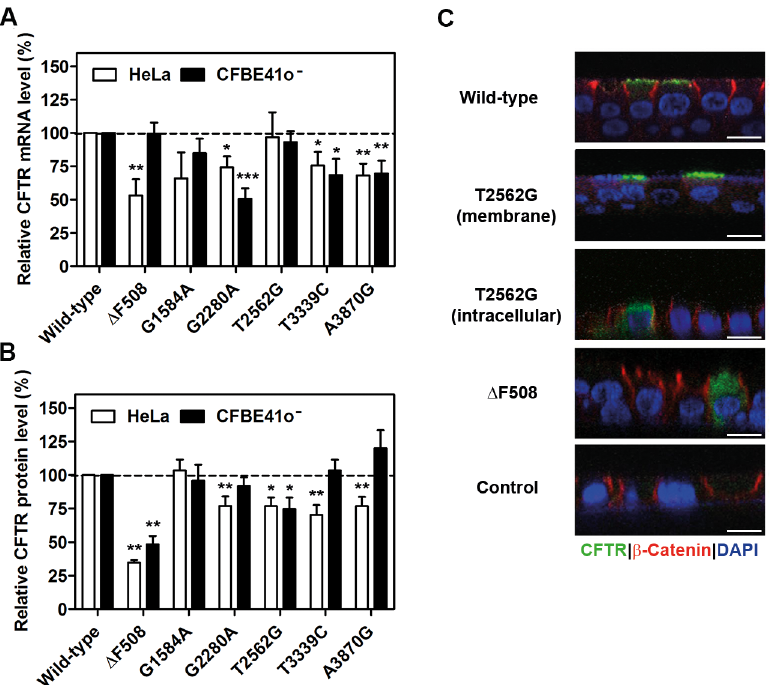
Fig 1. Synonymous mutations alter cystic fibrosis transmembrane conductance regulator (CFTR) expression. ( A ) Quantitative real-time PCR (qRT-PCR) quantificationof steady-state CFTR mRNA expressionin HeLa and CFBE41o - cells analyzed24 h after transfectionand normalized to neomycin phosphotransferase (NPT). The mRNA level of wild-type CFTR was set to 100%. ( B ) Total steady-state CFTR expression(i.e., the sum of bandsB and C in S1B Fig) normalized to that of NPT and β -actin(ACTB) and related to wild-typeCFTR, which was set to 100%. In A and B, data are means ± SEM (A: HeLa, n = 3–7; CFBE41o - , n = 4–9; B: HeLa, n = 5–14; CFBE41o - , n = 4–7); * P < 0.05, ** P < 0.01, *** P < 0.001 versus wild-typeCFTR. ( C ) Representative immunostaining images ( n = 3) of well-differentiated humancystic fibrosis (CF) airway epithelia.The frequencyof intracellularversus membrane-localizedT2562G-CFTR stainingwas as follows: 44% of T2562G-CFTR–expressing cells exhibitedintracellularstaining (12 out of 27) and in 55% (15 out of 27), staining was membranelocalized.The perinuclear stainingdemonstrates the intracellular localization of T2562G-CFTR. The control was non–CFTR-expressing epithelia. β -catenin immunostaining denotes adherens junctionsand DAPI—nuclei; scale bars, 10 μ m. The underlyingdata of panelsA and B can be found in S1